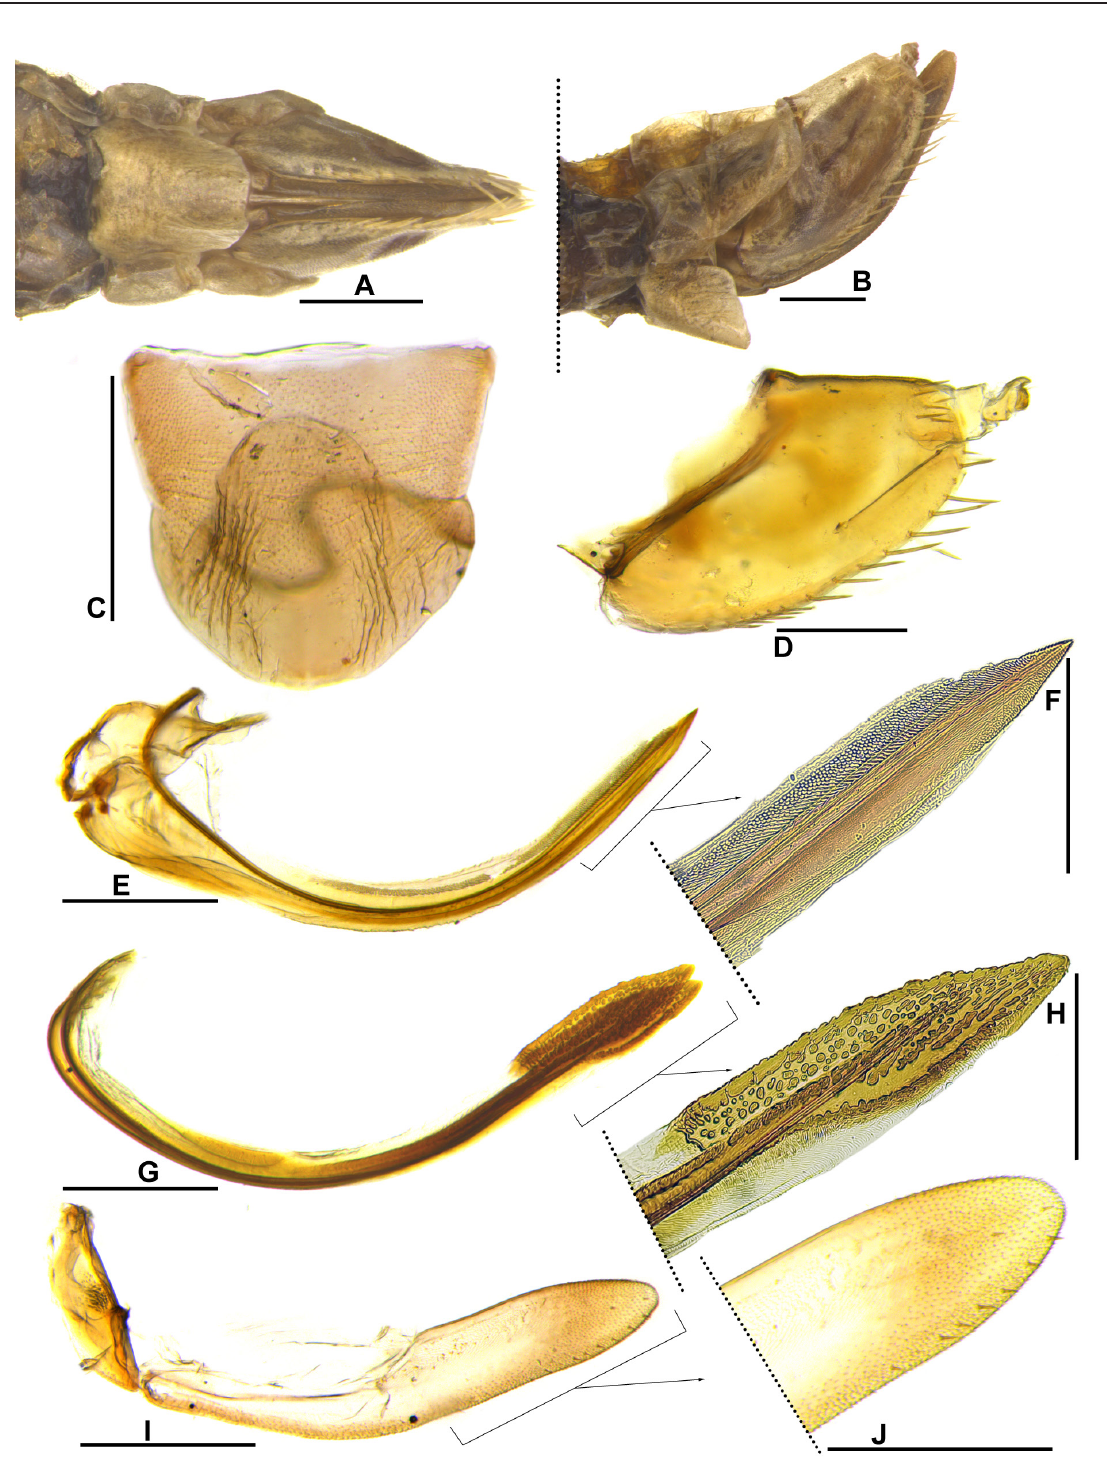
Fig. 6. Takiyaella coelhomarquesae gen. et sp. nov., ♀, paratype (DZUP-083606). A . Posterior portion of abdomen, ventral view. B . Posterior portion of abdomen, lateral view. C . Sternite VII, ventral view. D . Pygofer and anal tube, lateral view. E . First valvifer and first valvula of ovipositor, lateral view. F . Apex of first valvula, lateral view. G . Second valvula of ovipositor, lateral view. H . Apex of second valvula, lateral view. I . Second valvifer and gonoplac, lateral view. J . Apex of gonoplac, lateral view. Scale bars: A–B = 1.0 mm; C–E, G, I = 0.5 mm; F, H, J = 0.3